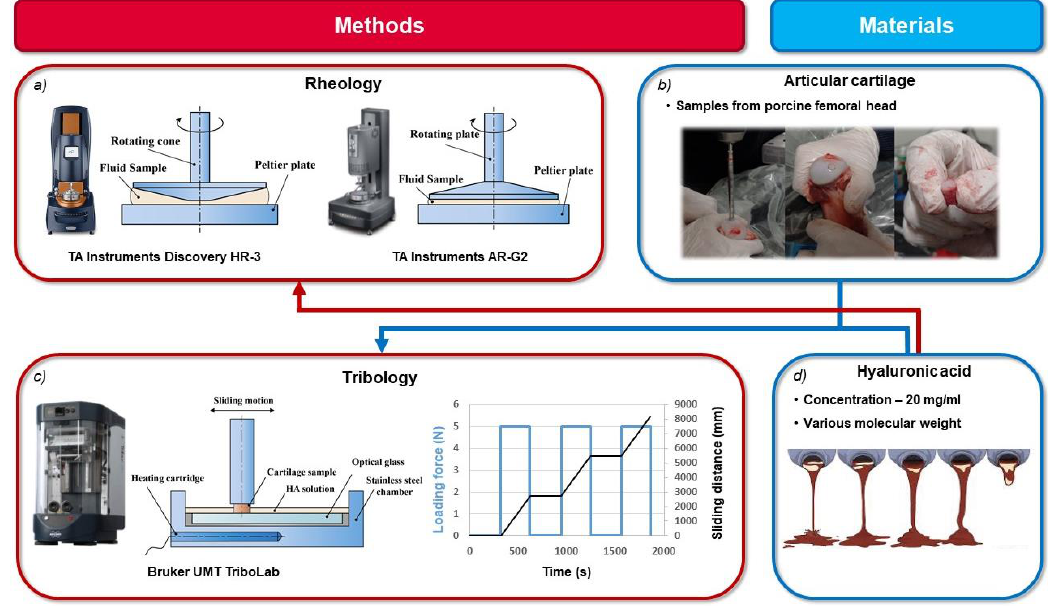
Figure 1. Scheme of research plan: ( a ) rheological measurements; ( b ) cartilage sample preparation; ( c ) frictional measurements; ( d ) tested solutions.